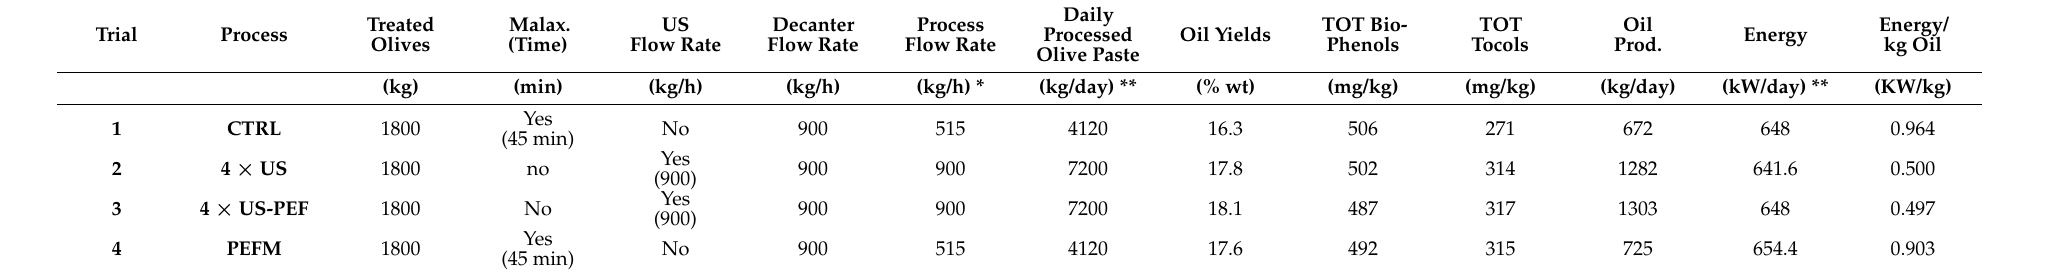
Table 4. Industrial trials: results summary.